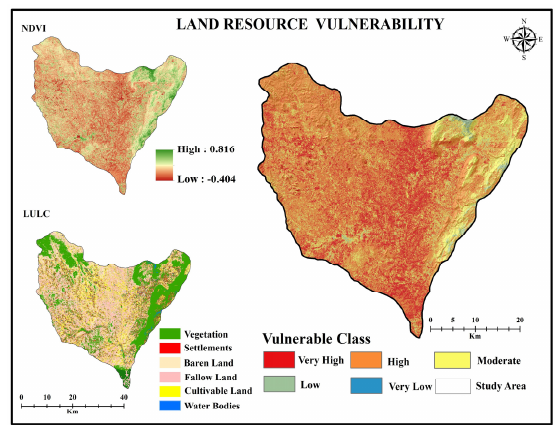
Figure 4. Land Resources Vulnerability